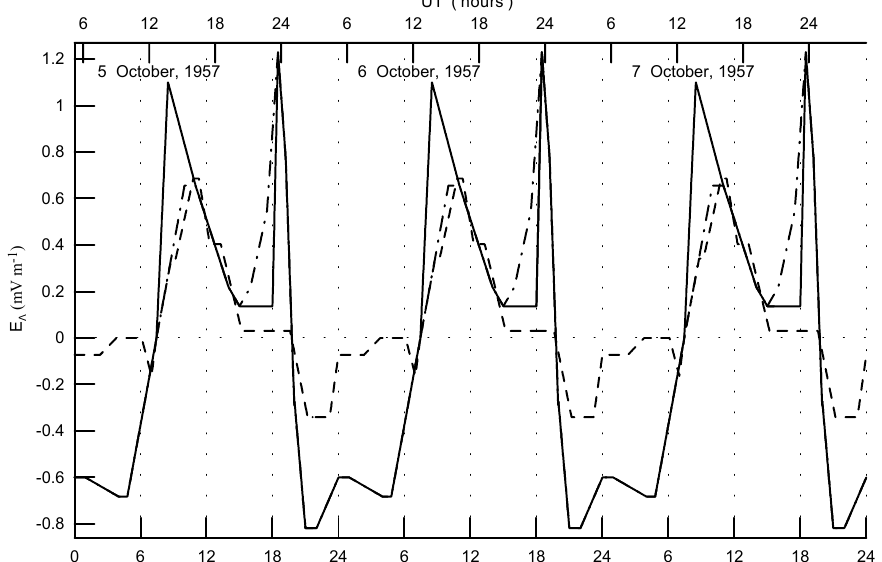
Fig. 1. Diurnal variations of E 3 on 7 October 1957. The empirical F-region quiet time vertical drift velocity over the geomagnetic equator presented in Fig. 8 of Scherliess and Fejer (1999) for high solar activity and equinox conditions was used to find the equatorial value of E 3 (dash-dotted line). Solid line shows the empirical equatorial electric field which was modified in the time range between 07:27 LT and 11:00 LT and between 15:00 LT and 18:30 LT by the use of the comparison between the measured and modelled values of Nm F2 and hm F2 at 00:00 UT and 16:00 UT. The average quiet time value of E 3 at the F-region altitudes over Arecibo (dashed line) is found from the average quiet time perpendicular/northward F-region plasma drifts for equinox conditions presented in Fig. 2 of Fejer